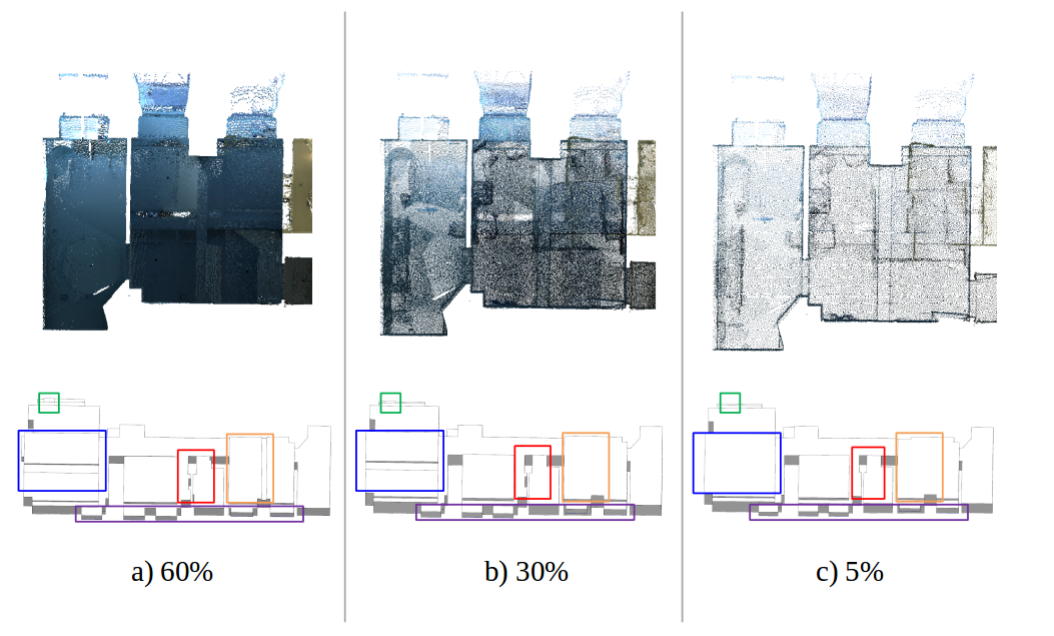
Figure 26. Sparse point clouds (with different downsampling rates) and corresponding output models: ( a ) sampling rate 60%; ( b ) sampling rate 30%; ( c ) sampling rate